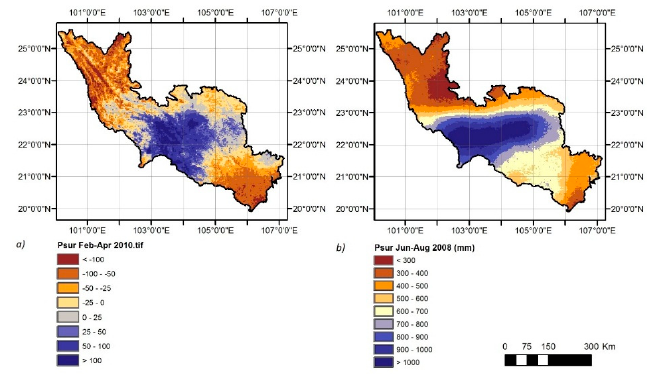
Figure 9. Rainfall surplus during February 2010–April 2010 ( a ) and June–August 2008 ( b ), respectively, the driest spring rice season and the wettest three-monthly period in the time series under consideration.